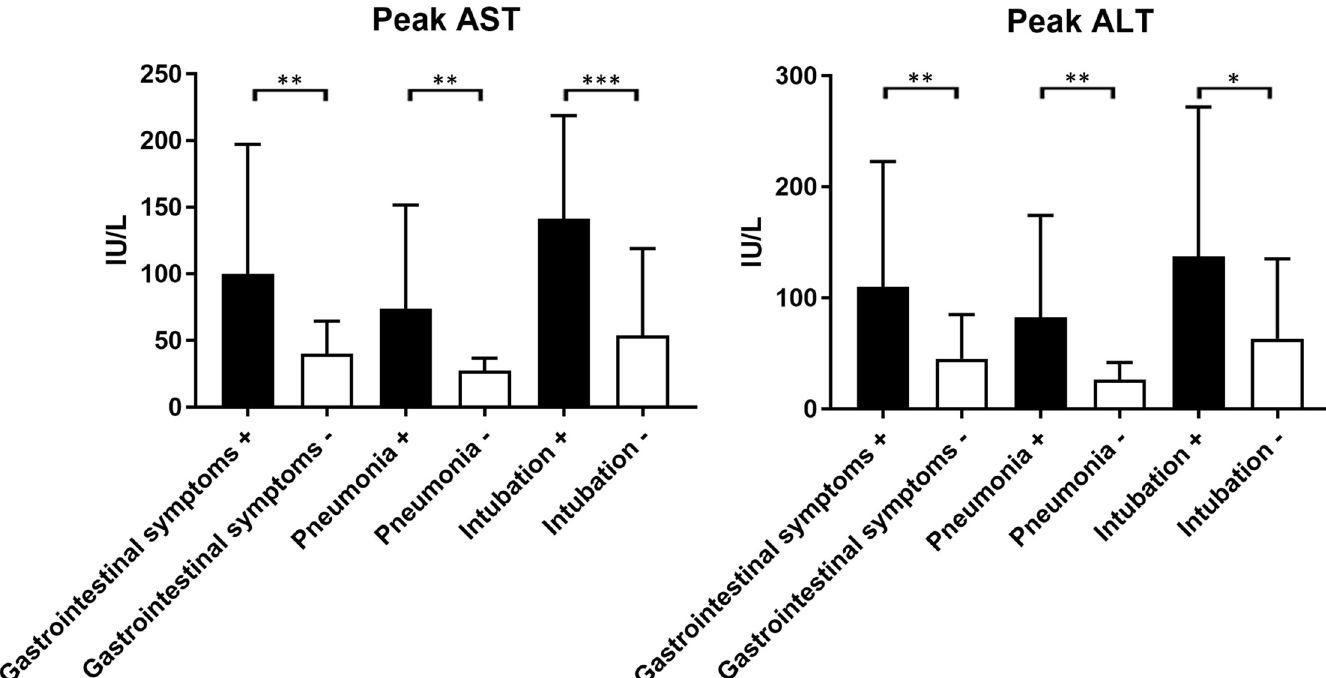
Fig 1. Liver enzyme at peak in patients with COVID-19 classified with or without gastrointestinal symptoms, pneumonia, and intubation; � P < 0.05, �� P < 0.01.